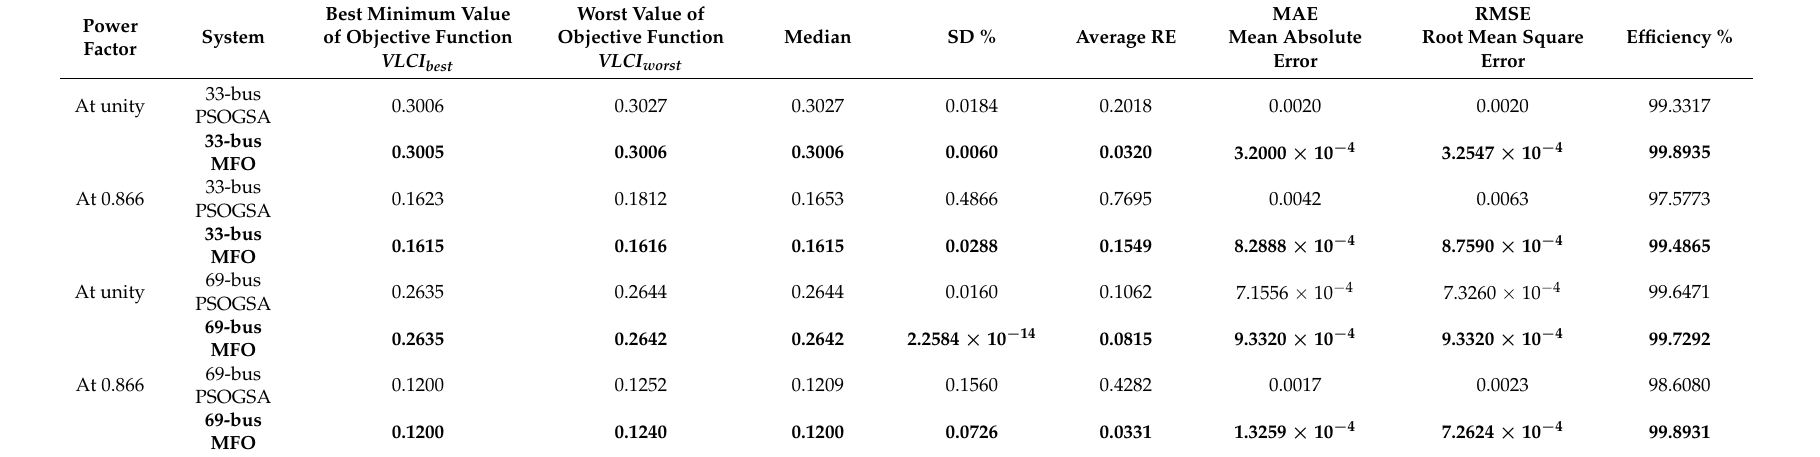
Table 9. Performance evaluation of PSOQN and PSOGSA algorithms under different cases “Number of runs is